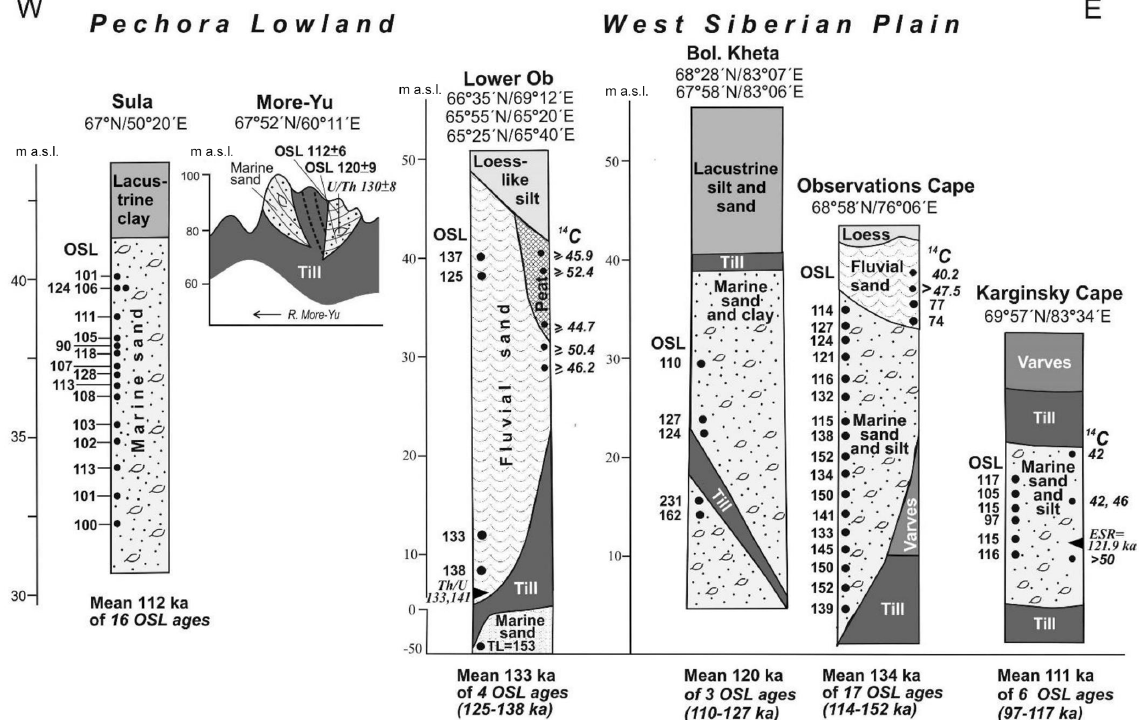
Figure 4. An overview of the best-dated sections of the LIG in the Russian Arctic mainland. Numbers along the columns are geochronometric ages (ka). Relative positions of samples are shown by black dots: large ones – dated by optical luminescence; smaller ones – dated by radio- carbon. Black triangles indicate dates by U / Th and ESR methods. Sources of information: Sula (Murray et al., 2007), More-Yu (Astakhov and Svendsen, 2002), Nadym Ob (Astakhov et al., 2004, 2005), Observations Cape (Astakhov and Nazarov, 2010a, b), Bol’shaya Kheta (Nazarov et al., 2020), and Karginsky Cape (Astakhov, 2013; Nazarov et al., 2020). These stratigraphic sections are sometimes summaries of several sites; see text for details. Comprehensive documentation of each site (including detailed sea-level measurements and chronological data) is available at https://doi.org/10.5281/zenodo.5602212 (Dalton et al.,